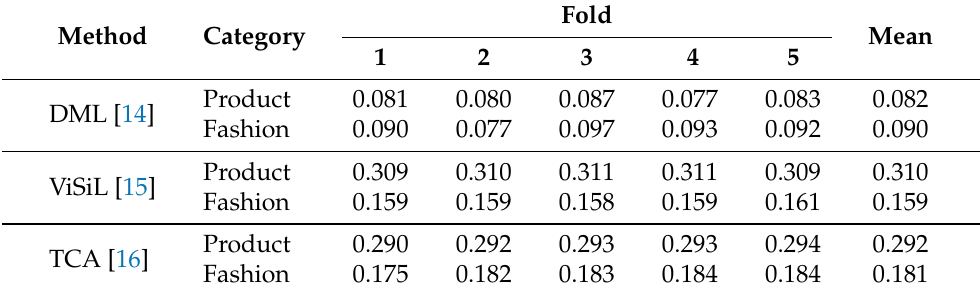
Table 1. Benchmark results of applying VERD to existing video retrieval